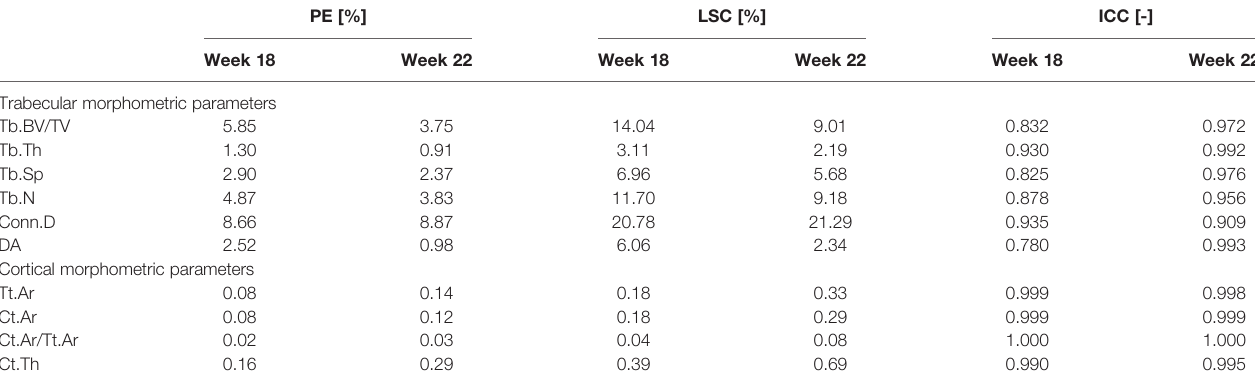
TABLE 1 | Intra-operator reproducibility of morphometric parameters.